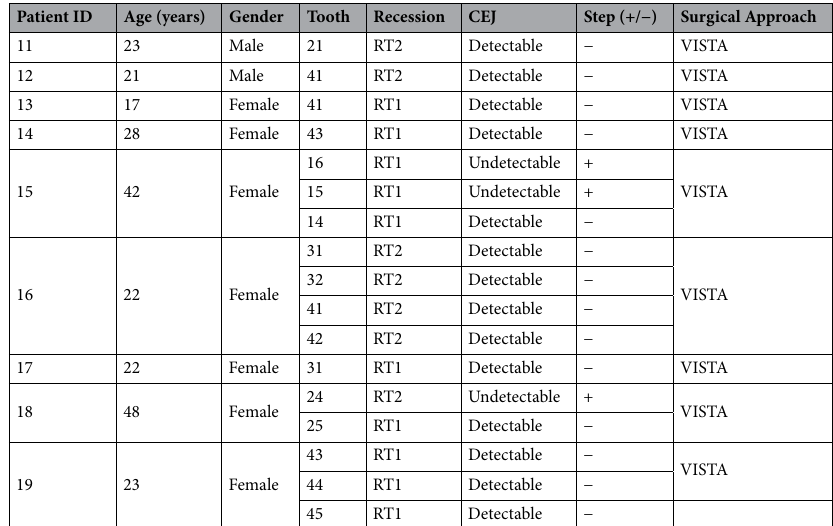
Table 2. Patients’ and site-specific characteristics for the VISTA technique. Recession Cairo’s recession classification, CEJ cementoenamel junction, Class A detectable CEJ, Class B undetectable CEJ, Step root surface concavity, + presence of a cervical step, − absence of a cervical